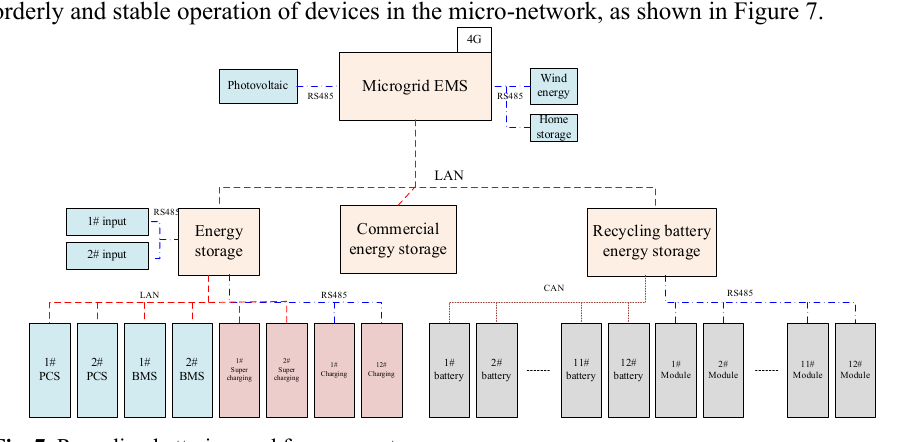
Fig. 7. Recycling batteries used for energy storage.